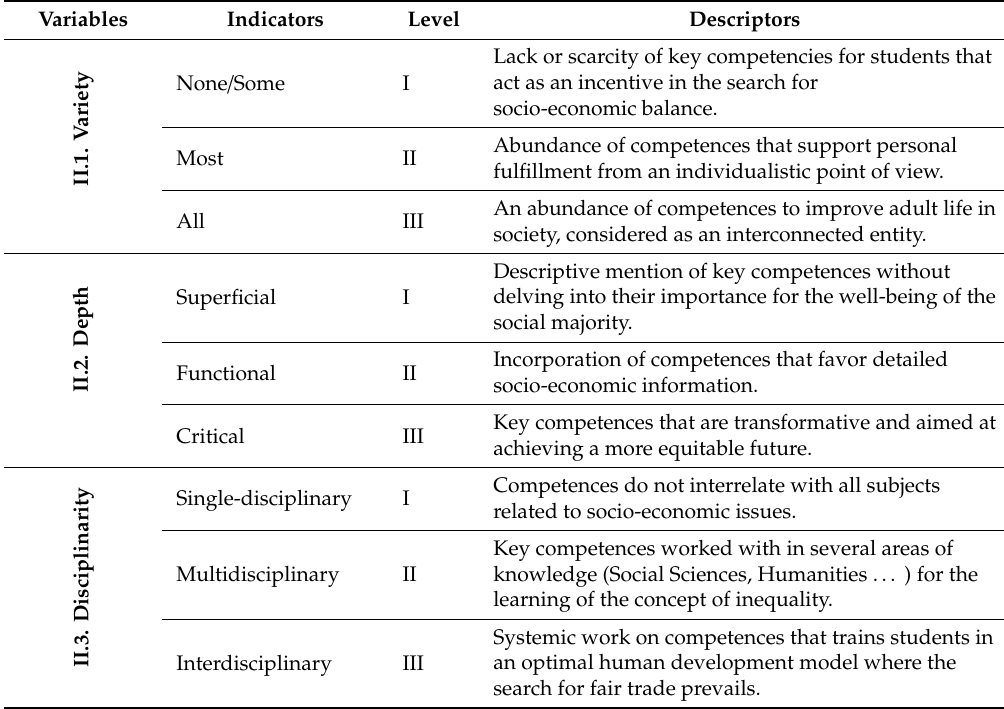
Table 5. System of categories by levels of complexity ( Category: II. Competences ).